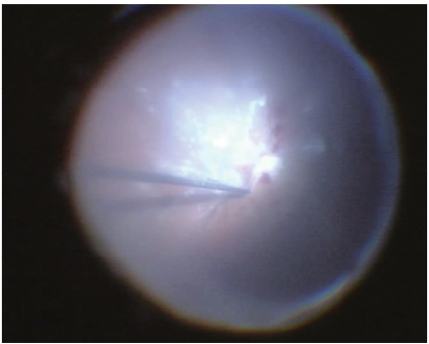
Figure 2: Fundus image shows induction of posterior vitreous